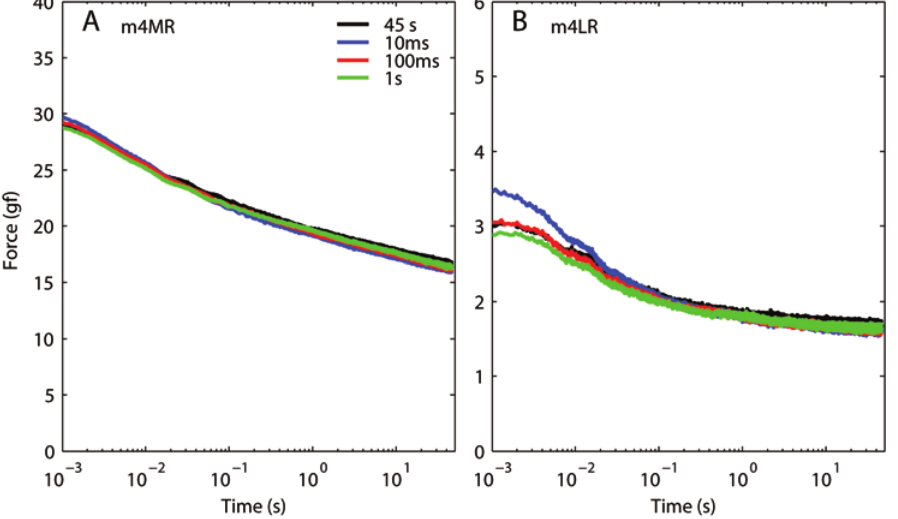
Figure 13. Force induced by the second step in a double-step sequence. A : Data from elongations at long lengths, same dataset as in Fig. 11 . The force induced by the second elongation step is not a function of the ISI. B : Data from elongations at short lengths, same dataset as in Fig. 12. With the exception of the first 20 ms after the shortest ISI, the force induced by the second elongation step is invariant. The muscle thus appears to have no memory of the previous elongation.